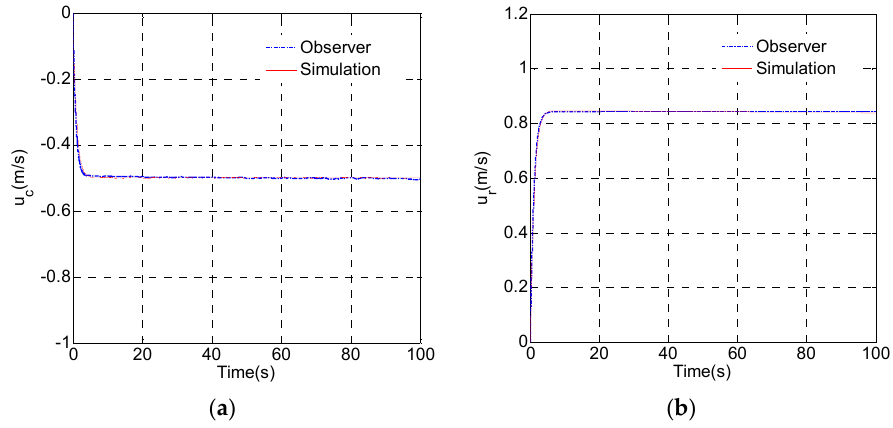
Figure 22. Observed result of velocity: ( a ) current velocity in the X direction; ( b ) relative velocity of ROV in the x direction.